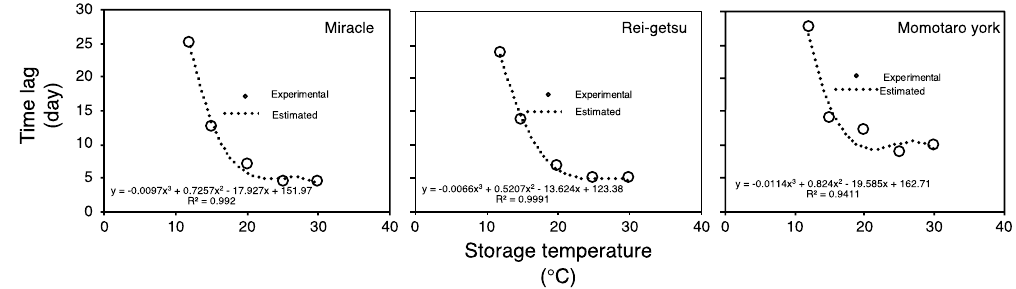
Figure 4. Relationship between time lag of red color development and storage temperature of tomato cultivars Miracle, Rei-getsu, and Momotaro York. Dotted lines denote cubic functions for each variety. Time lag was obtained using Eq. (2) with the average α, β, and γ from five (n = 5) biological replicates.